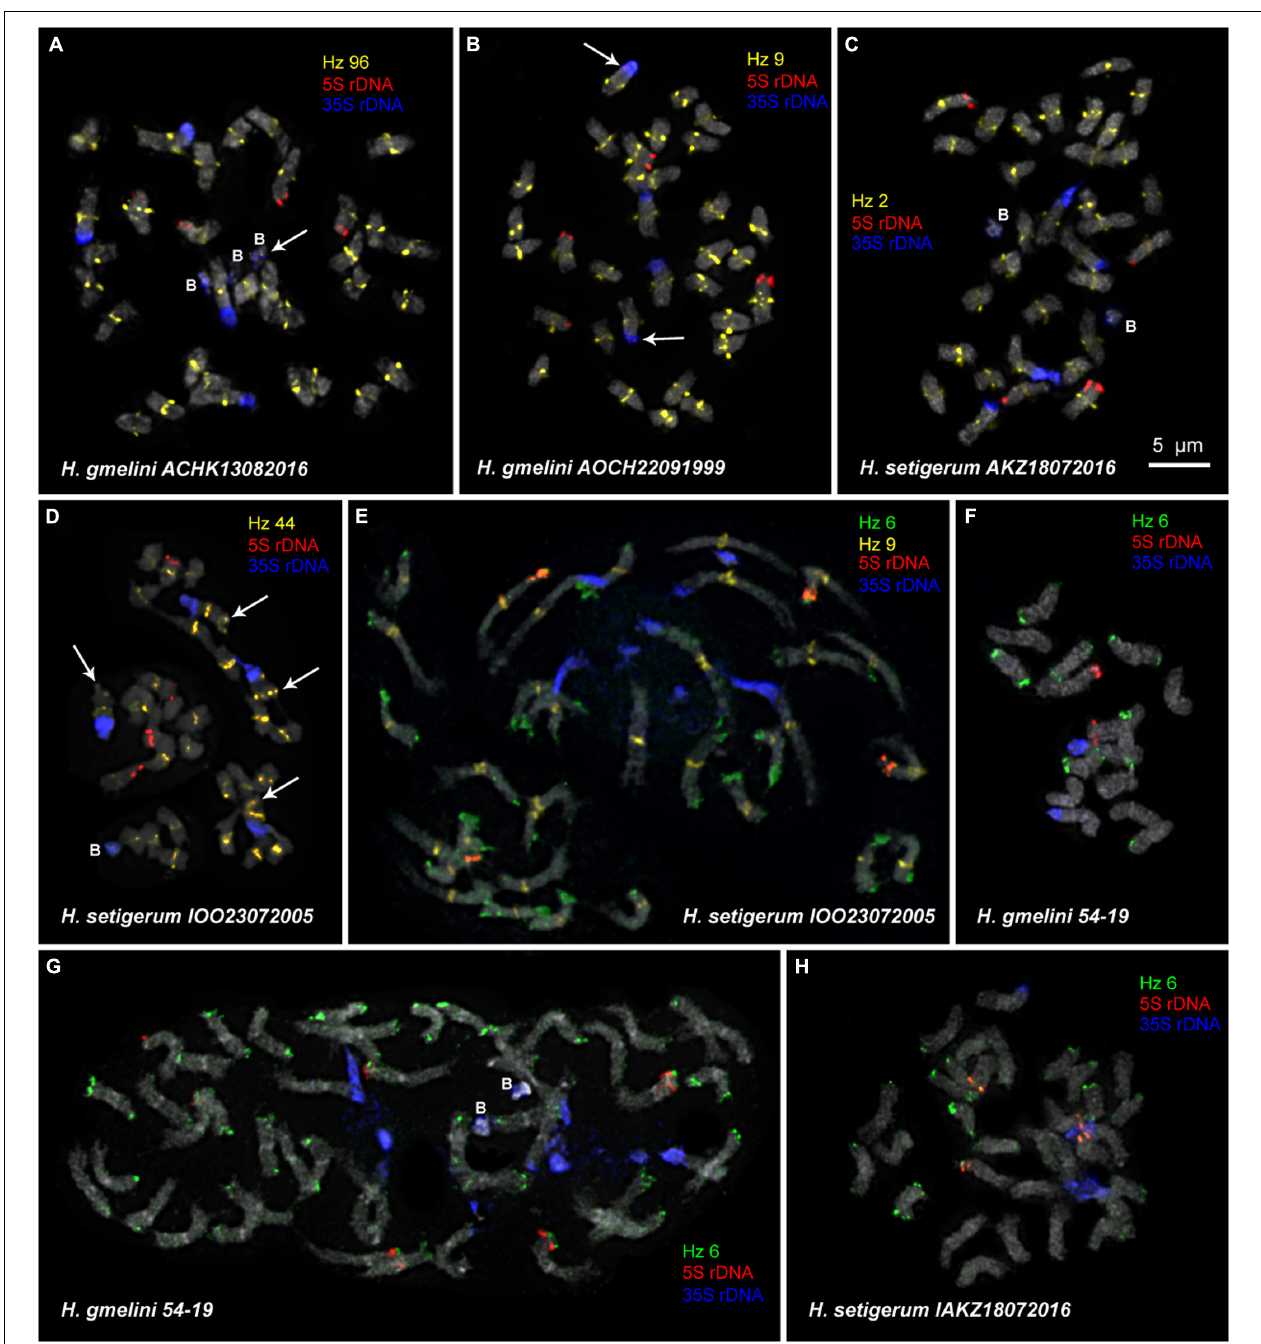
FIGURE 5 | FISH-based localization of 5S rDNA, 35S rDNA, and satellite repeats in metaphase spreads of the studied accessions of H. gmelinii (A,B,F,G) and H. setigerum (C–E,H) . The correspondent probes and their pseudocolors are specified next to the metaphase spreads. Arrows point to the Hz 96 site on the B chromosome of H. gmelinii (A) and to small 5S rDNA sites (co-localized with 35S rDNA sites) on the satellite chromosomes of H. gmelinii (B) . Arrows point to the Hz 44 sites on the long arms of satellite chromosomes of H. setigerum (D) . B, B chromosomes. Bar—5 µ m.